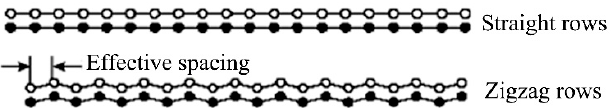
Figure 10. Schematic illustration of the two types of matching directions, reproduced from Reference [64], with permission of Elsevier, 2005.